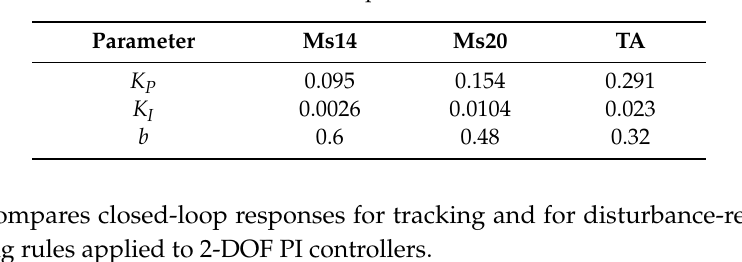
Table 8. PI controller parameters for Case 3.